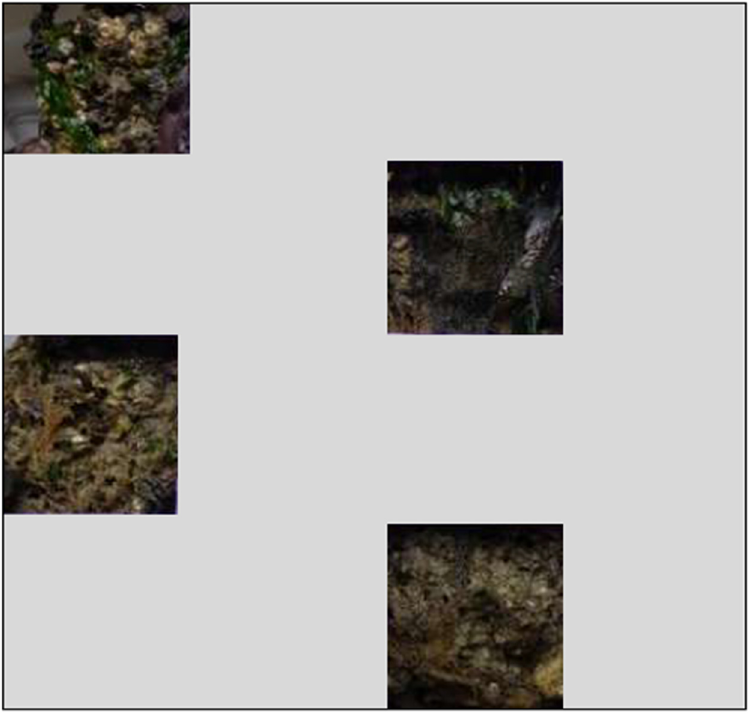
Figure 3. Photo of a block showing a mask of 5 × 5 cm, i.e., 25 cm 2